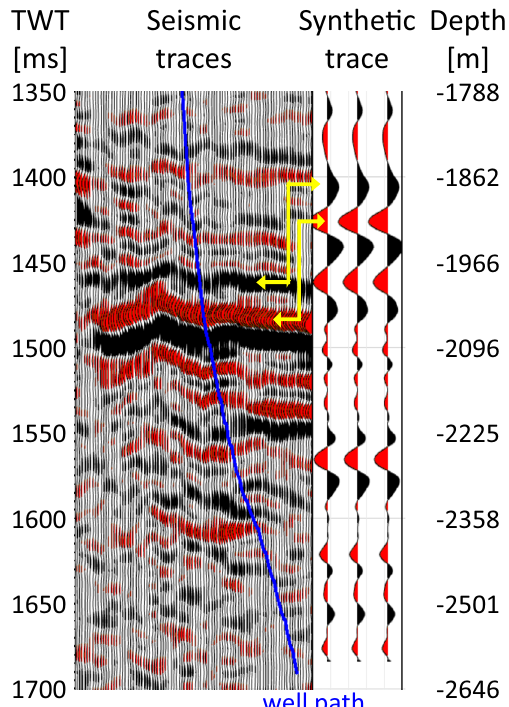
Fig. 6 Correlation of the seismic data in time domain (on the left) and the well data in depth domain (on the right), also called seismic-well tie. A synthetic trace derived from the sonic and density logs and the corresponding well tops, derived from a lithology log, were shifted to match it with the reflectors of a seismic trace, extracted from the 3D seismic near the well paths, and the interpreted horizons in time. The seismic-well tie was improved by visual examination and manual stretching and squeezing of the synthetic trace to extract a wavelet and to generate a time-to-depth (TDR) curve for the corresponding